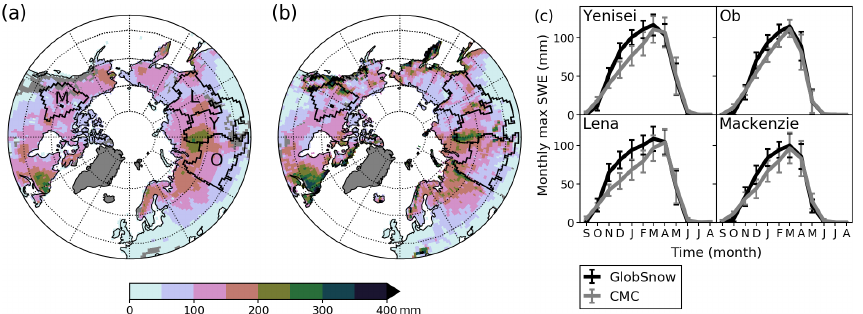
Figure 1. Seasonal maximum SWE (mm) for (a) GlobSnow and (b) CMC for the common overlap period, 2002–2010. The basins used in this study are labelled with their initial letters ( Y enisei, O b, L ena and M ackenzie). Grey shows regions that are masked. In both data sets Greenland is masked. In addition, GlobSnow pixels are masked where they are more than 50% “mountain”. (c) Mean monthly climatology is averaged over the basins (masked using the GlobSnow mountain mask) for the common overlap period, 2002–2010. Error bars show the inter-annual variability, defined as the standard deviation between